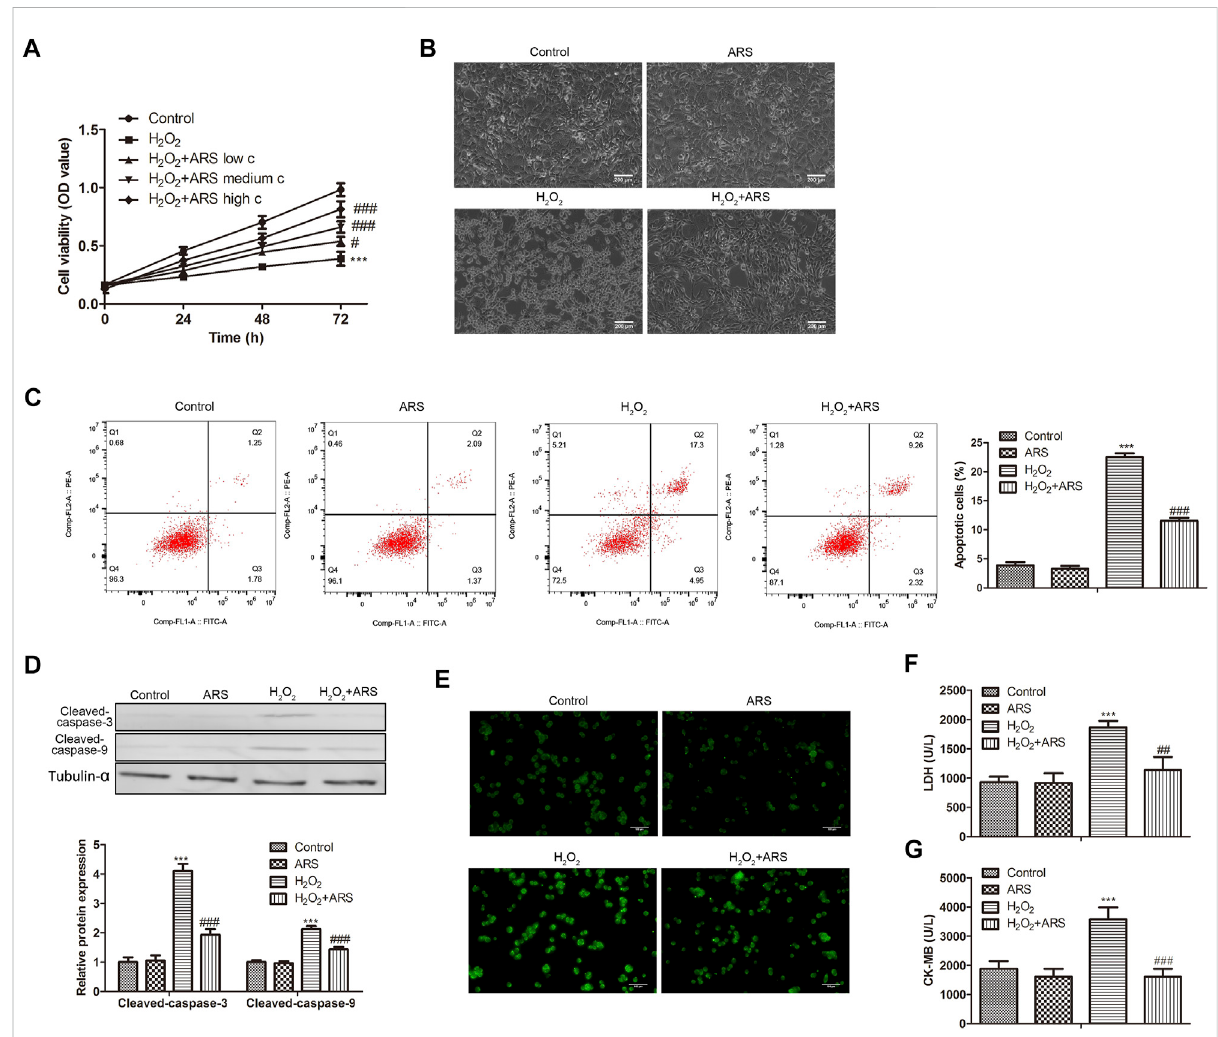
FIGURE 1 ARS suppresses H 2 O 2 -induced myocardial I/R injury. Proliferation, morphological changes, apoptosis, apoptosis-related protein, and oxidative stress biomarker in H9c2 cells via (A) CCK-8, (B) inverted phase contrast microscope (200 μ m), (C) Flow cytometry, (D) Western blotting, (E)